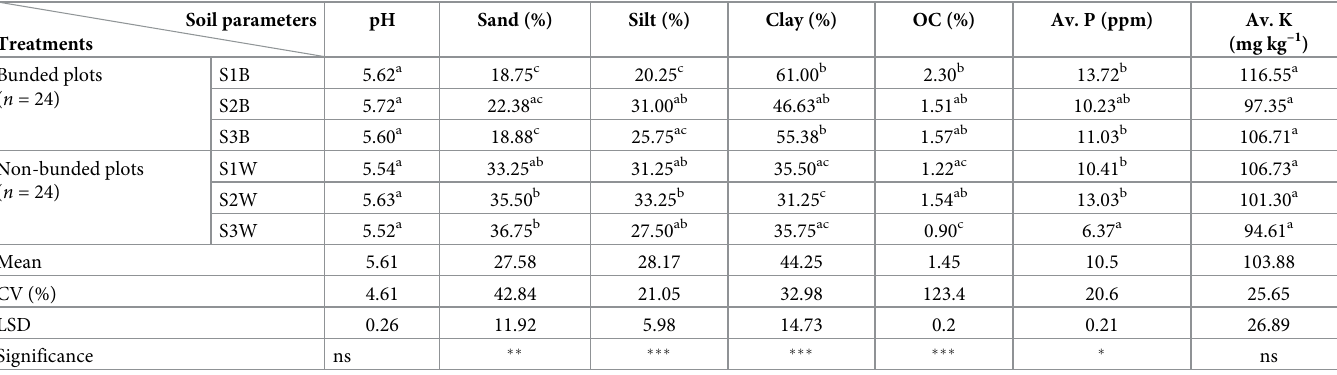
Soil parameters pH Sand (%)